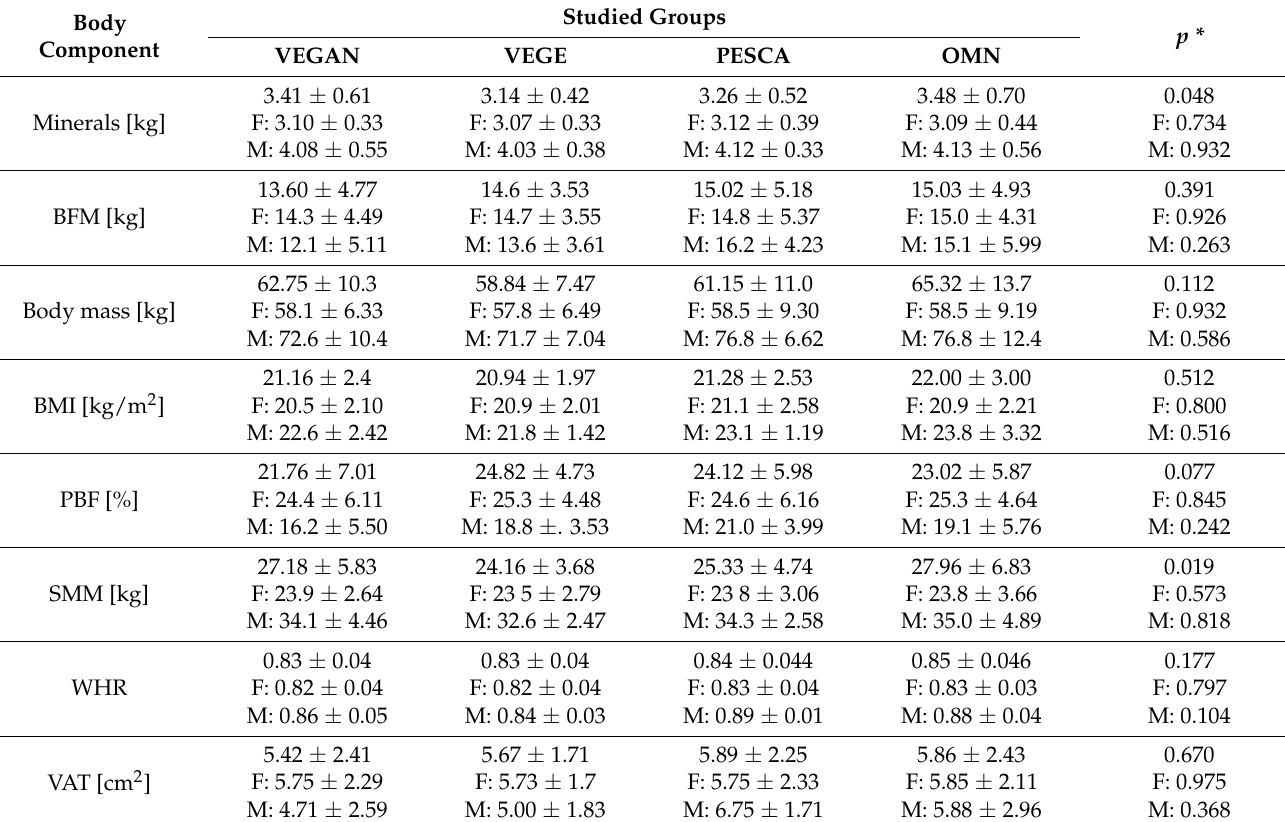
Table 4. Characteristics of the main body composition parameters in the studied groups.